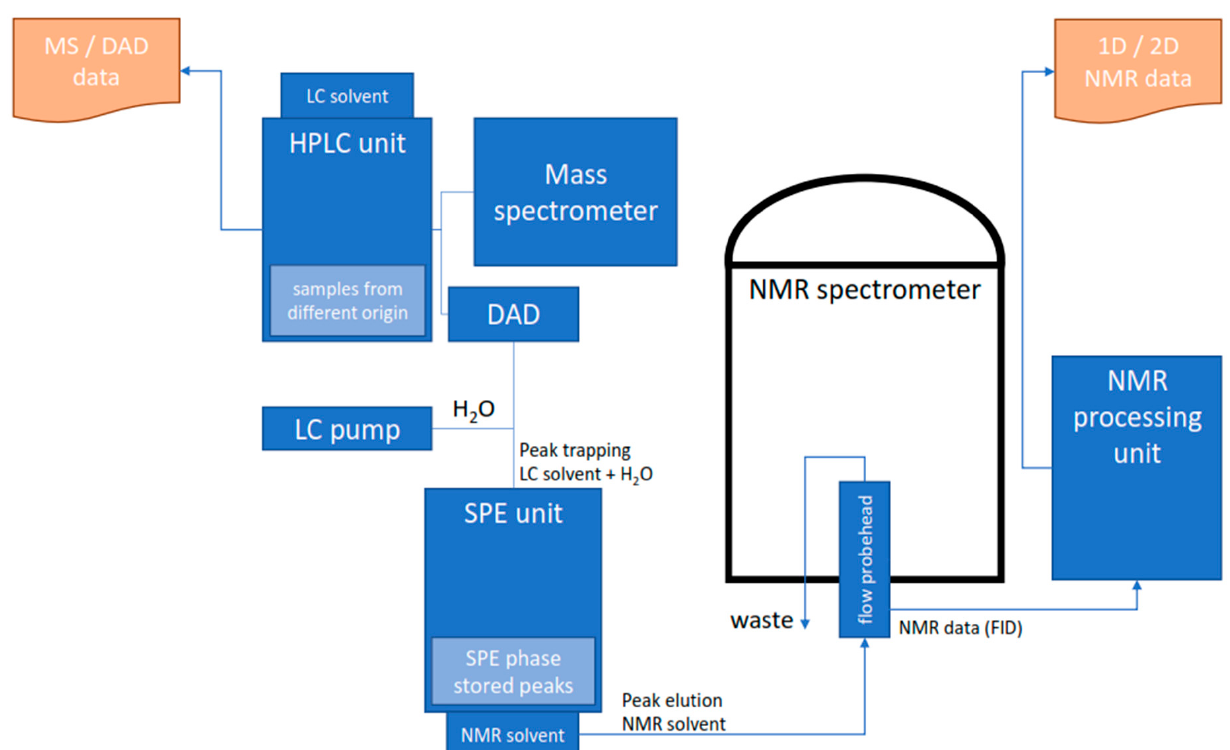
Figure 3. Schematic diagram of an HPLC-MS/DAD-SPE-NMR system. Analytes separated in the HPLC system are trapped post-column in an SPE device using a make-up flow to increase the effluent polarity. Trapping events are triggered by UV or MS signals; hence, automation and multiple trapping events are possible. The SPE cartridges are rinsed and dried to remove the HPLC solvent; and the subsequent analyte transfer to the NMR spectrometer is performed with an appropriate NMR solvent, e.g., ACN-d3, MeOD-d4, or CDCl 3 .